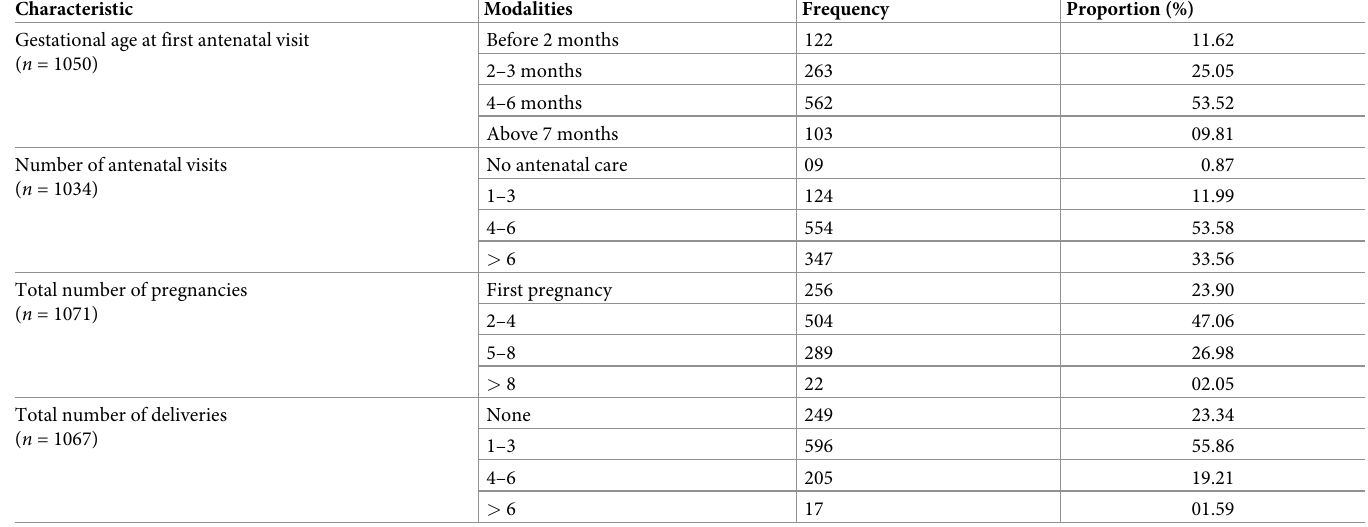
Table 2. Obstetric characteristics of participants.